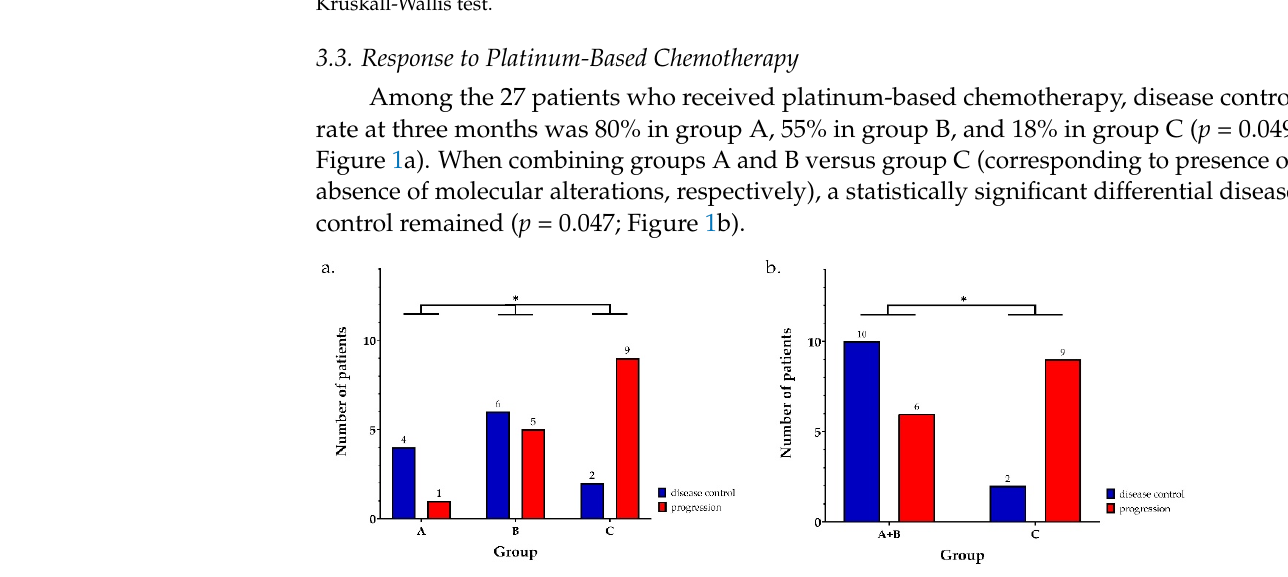
Figure 1. Response to platinum-based therapy according to molecular status phenotype . Responses are given for each group taken separately ( a ), or by comparing patients with or without molecular alteration (groups A + B versus group C respectively) ( b ). * represents differences with statistical significance ( p < 0.05).